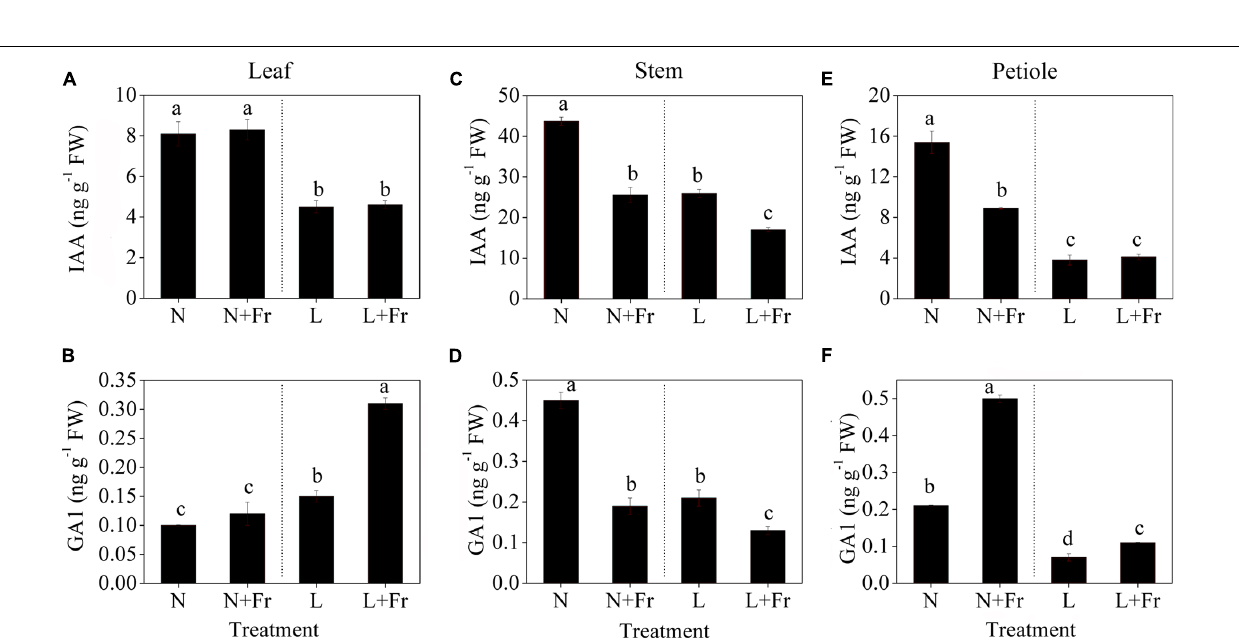
Frontiers in Plant Science | www.frontiersin.org